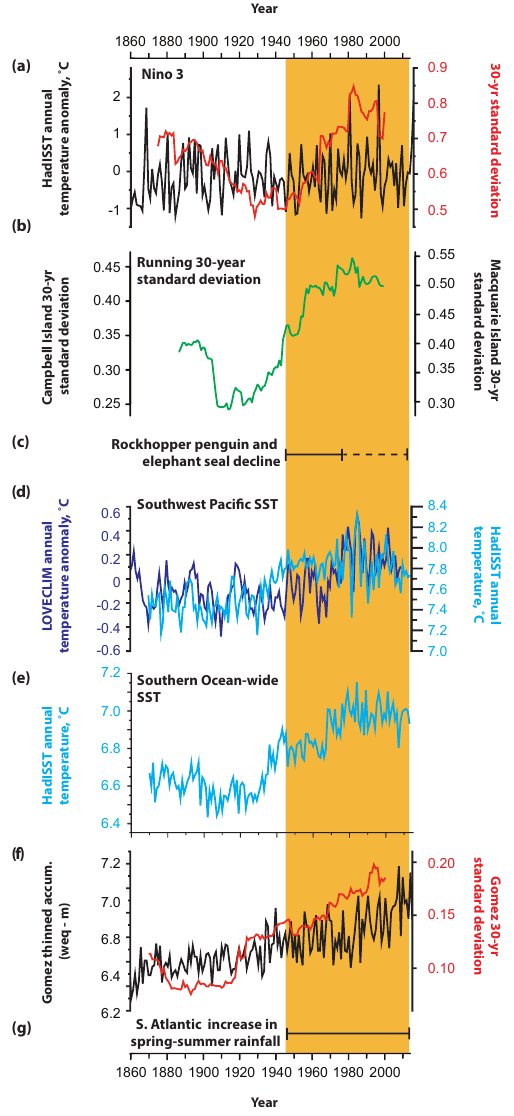
Figure 9. Equatorial and South Pacific temperature and marine population trends since CE1860. Nino 3 temperature (July–June) with running 30-year mean standard deviation of the HadISST tem- perature series (Rayner et al., 2003) (a) compared to Campbell Is- land and Macquarie Island running 30-year mean standard deviation of the reconstructed temperature series (b) . Orange column denotes twentieth century temperature variability that exceeds any other pe- riod in the record. Onset (solid line) and continuing (dashed) period of declining rockhopper penguin and elephant seal populations in the southwest Pacific (Morrison et al., 2015; Weimerskirch et al., 2003) (c) shown for comparison. In addition, mean annual tem- perature ( ◦ C, July–June) sea surface temperatures (HadISST and LOVECLIM model output) for the Campbell–Macquarie islands region (d) and wider Southern Ocean (e) . Note the coincident in- crease in West Antarctic Coast (Gomez) (annual and 30-year mean standard deviation) (Thomas et al., 2015, 2008) (g) and South At- lantic (Falkland Islands and South Georgia) precipitation (Turney et al., 2016a) (f)